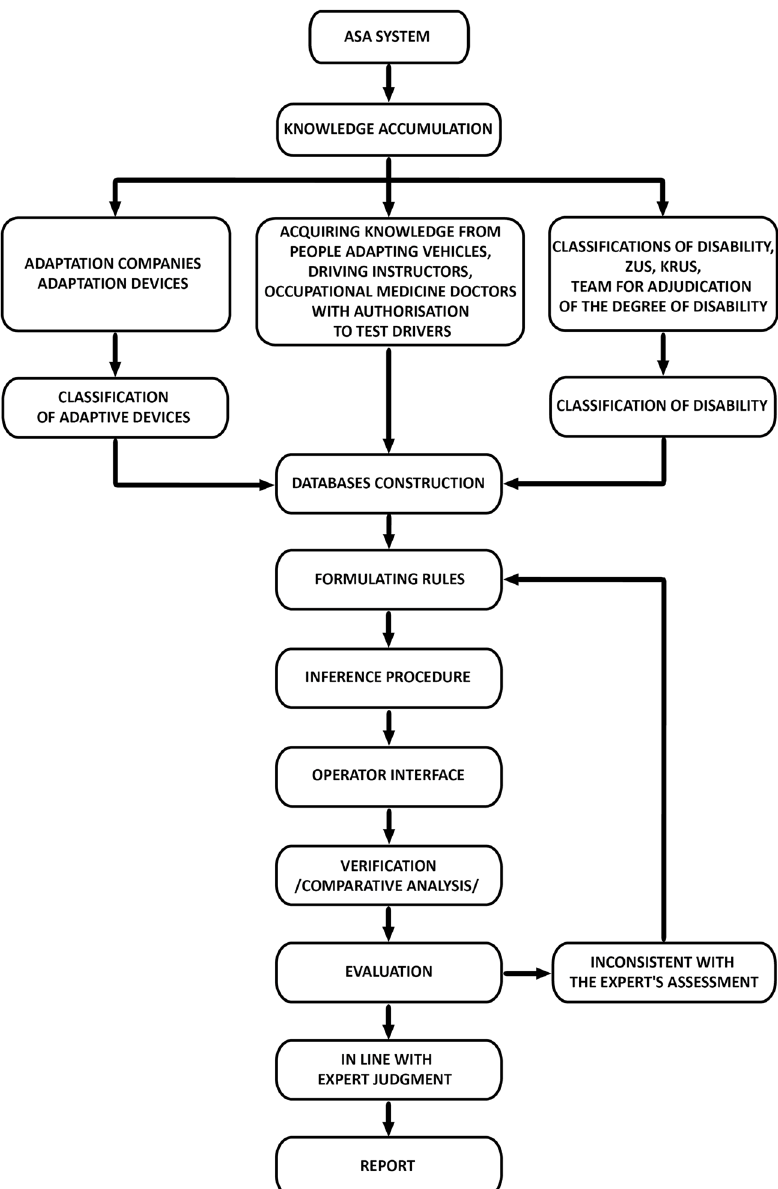
Figure 1: The algorithm for building a method of automatic adaptive devices selection, ASA